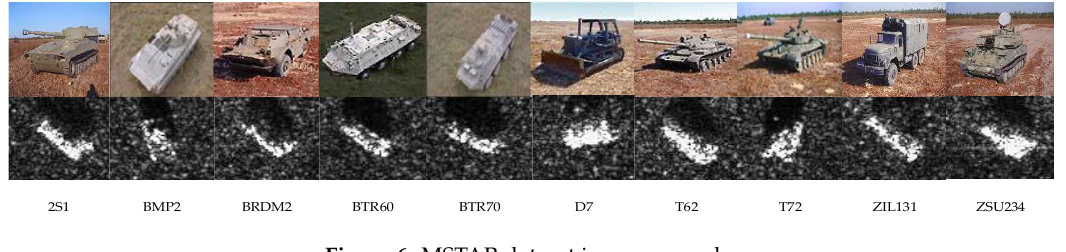
Figure 5. Transfer prior knowledge of non-optical images.